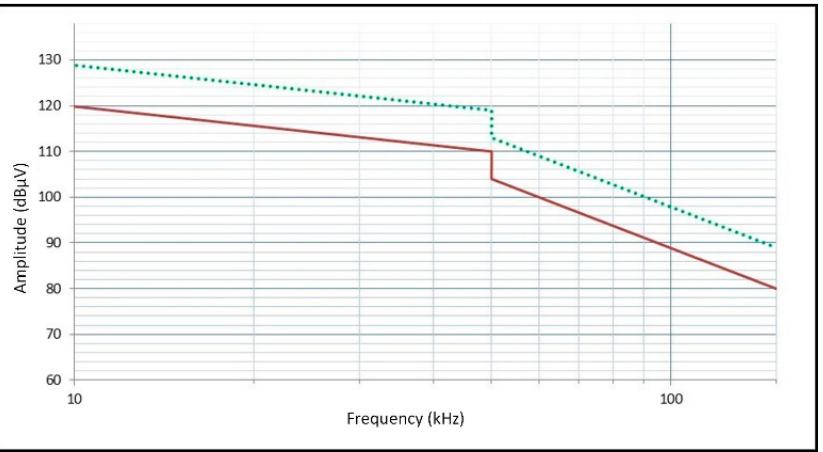
Figure 3. Compatibility level (green curve, dotted) and emission limit proposed in CIS-H/JWG6 (red curve, plain).